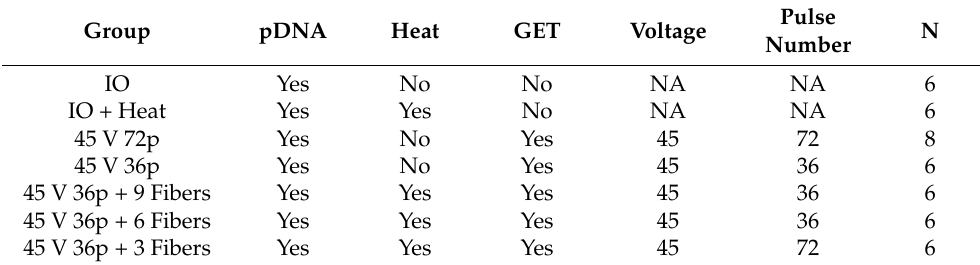
Table 2. Kinetics of moderate heat-assisted GET—fiber variation.